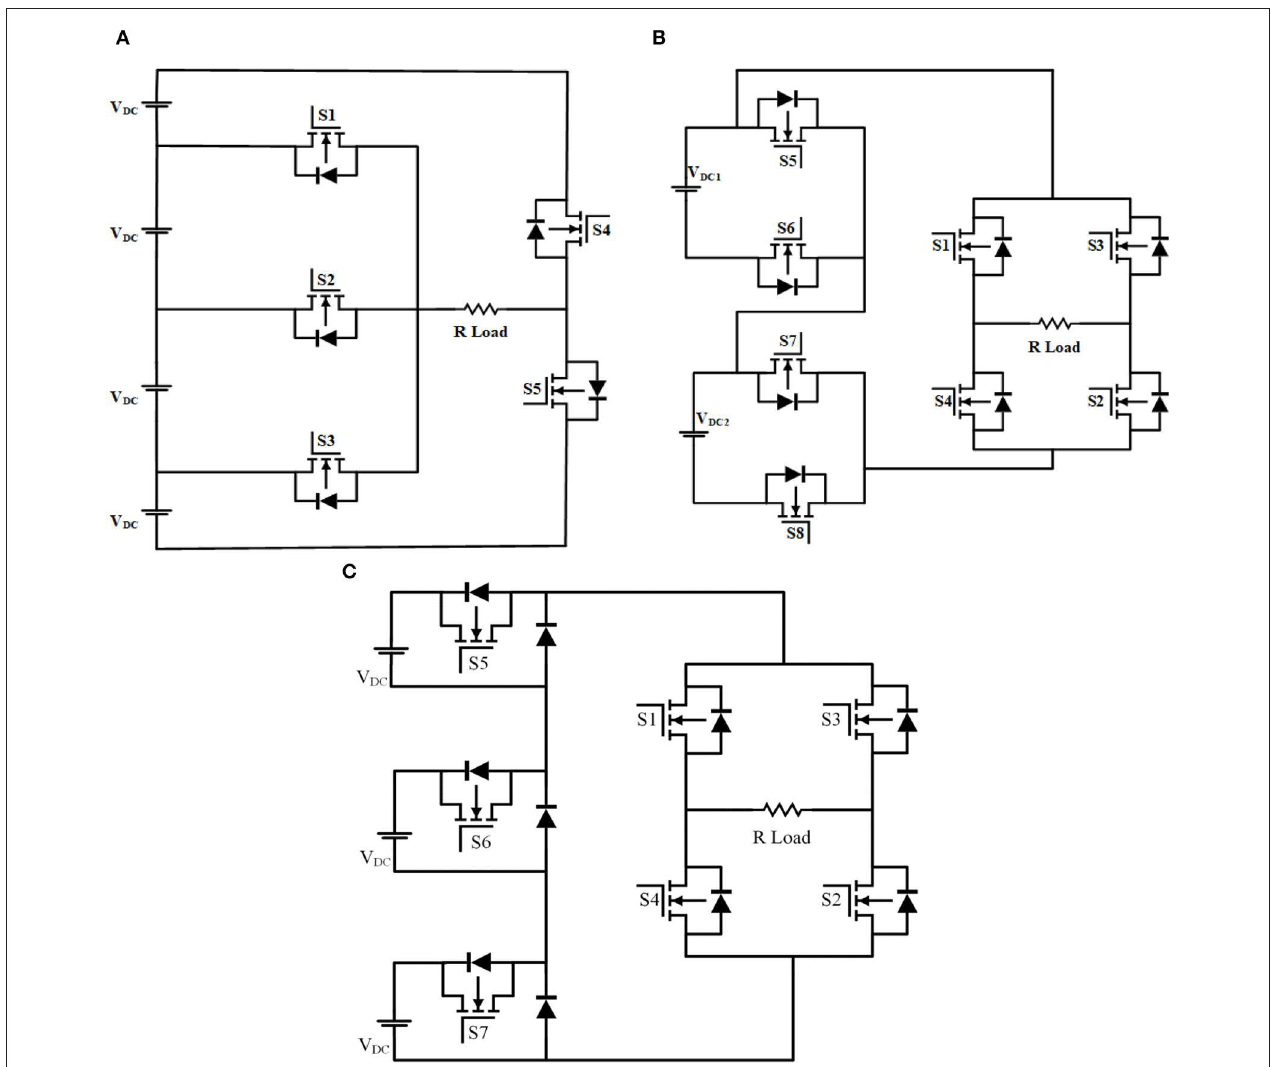
FIGURE 1 | Various seven-level MLIs. (A) Reduced switch MLI. (B) DC link MLI. (C) SCSD MLI.